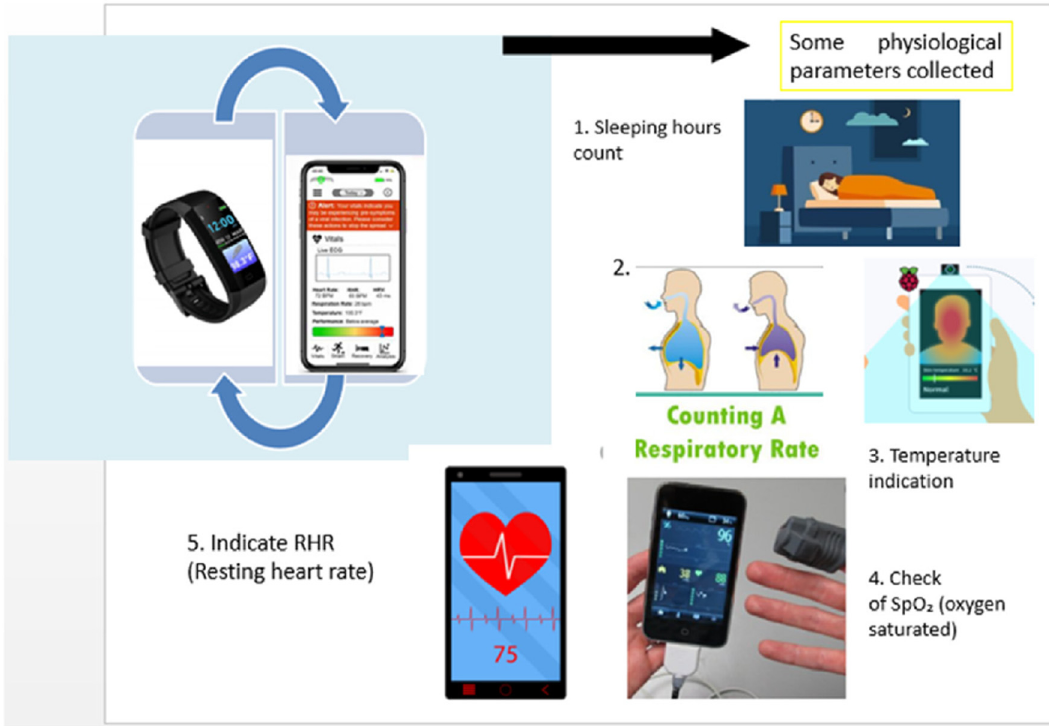
Figure 13: Schematic detailing of a smartphone application [ 83 ]